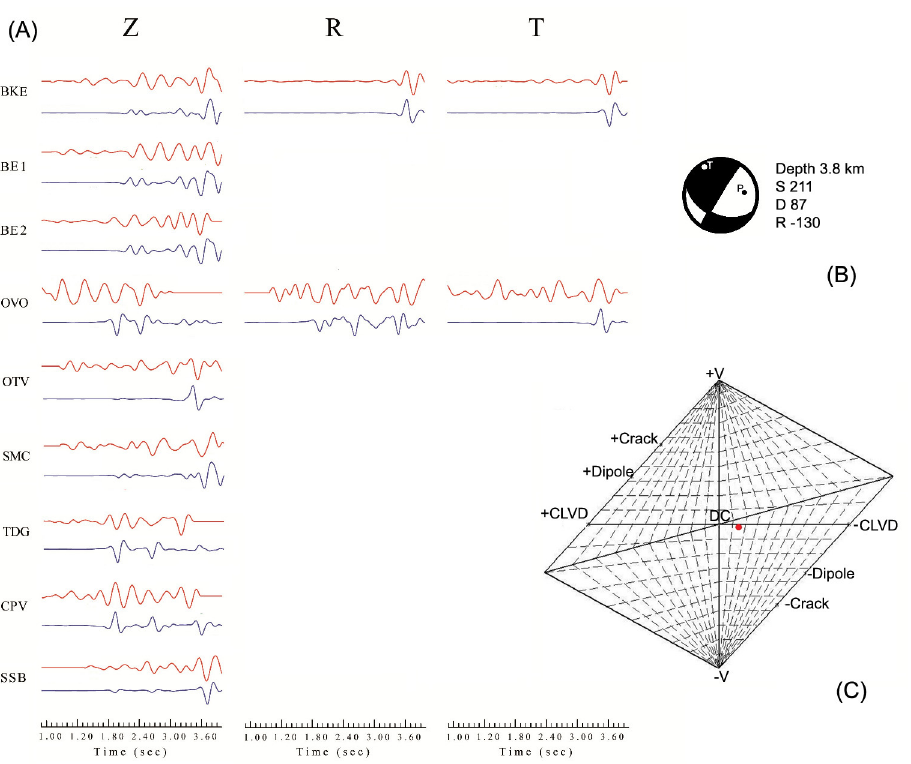
Figure 8. Seismic Moment Tensor inversion results. (A) Comparison between the real seismic signals (red lines) of the LP event and the syn- thetics (blue lines) generated for the best source retrieved by the inversion. Z is the vertical, R the radial and T the transversal component of the ground velocity. (B) The retrieved double couple mechanism is reported with the associated geometric parameters (S = strike, D = dip and R = rake). P (compressional) and T (tensional) axes are indicated. (C) Source-Type Plot of k (vertical coordinate) and T (horizontal coordinate) parameters. The loci for pure DC, CLVD, dipole, crack and isotropic (V) source are marked. The red circle corresponds to the k and T values calculated for the LP